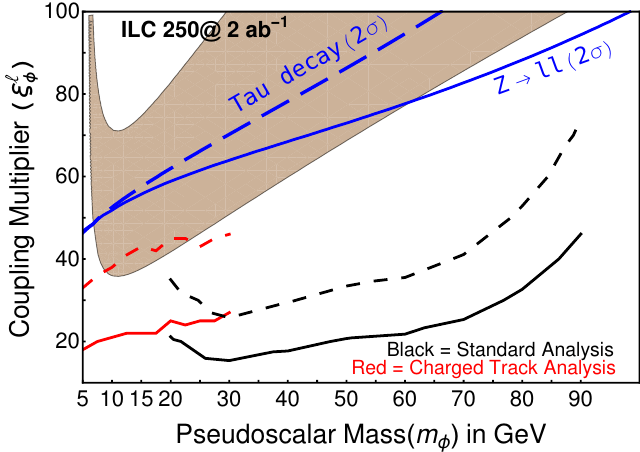
Figure 4 . Parameter space in the pseudoscalar extended 2HDM model where the light additional pseudoscalar explain the ( g − 2) µ anomaly. Strong constraints on the parameter space comes from the lepton universality in the Z and τ decays. Although substantial parameter space is allowed from lepton universality, ILC will be able to explore the entire parameter space. Limit from ILC is shown in red and black curves where solid and dashed line corresponds to exclusion( 2 σ ) and discovery( 5 σ ) limit at ILC250 with 2 ab − 1 of data. Limit of conventional analysis is taken from ref